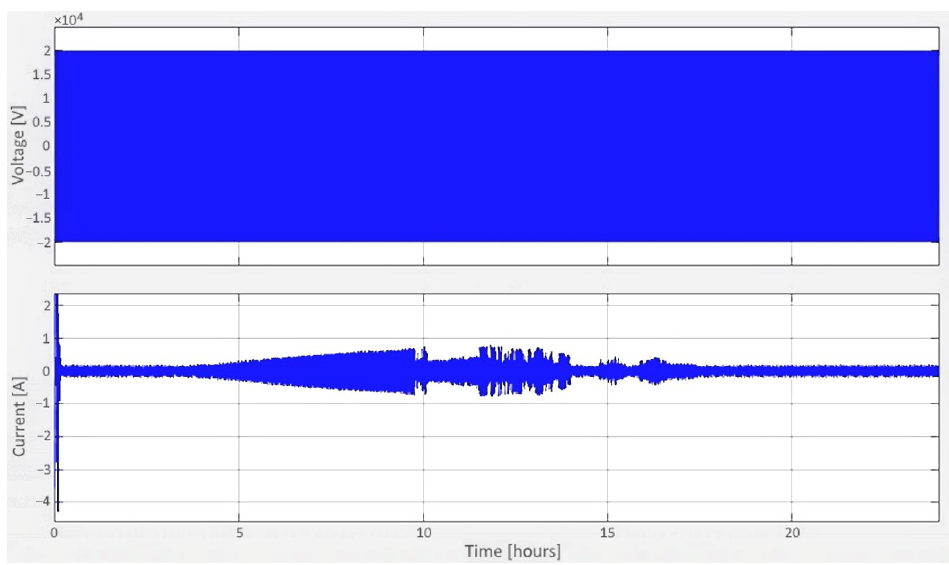
Figure 26. Daily waveforms of voltage and current in the grid, phase A on a sample day in July.